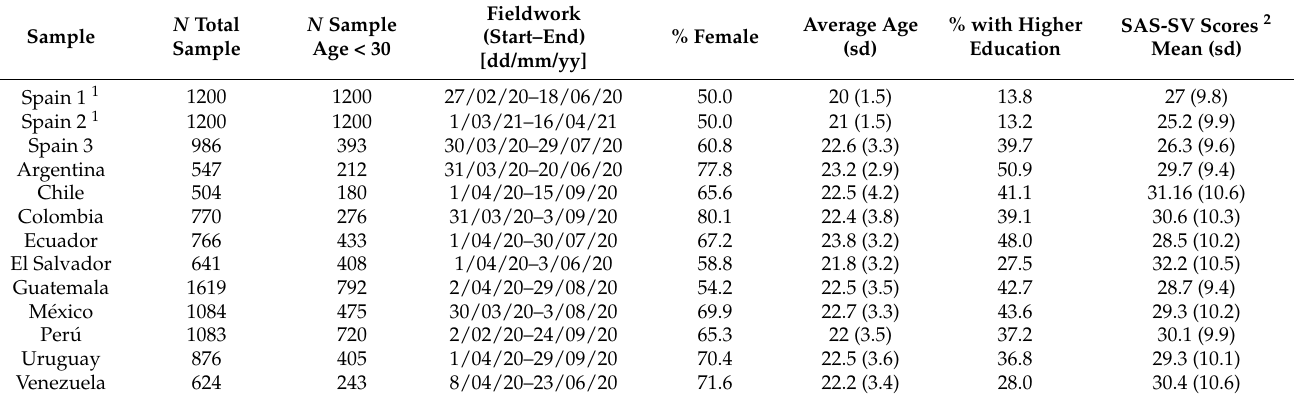
Table 2. Samples, collection information, demographic characteristics, and SAS-SV